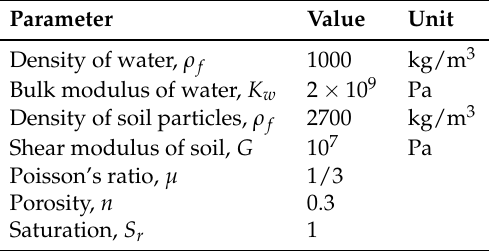
Table 1. Parameters of water and soil.